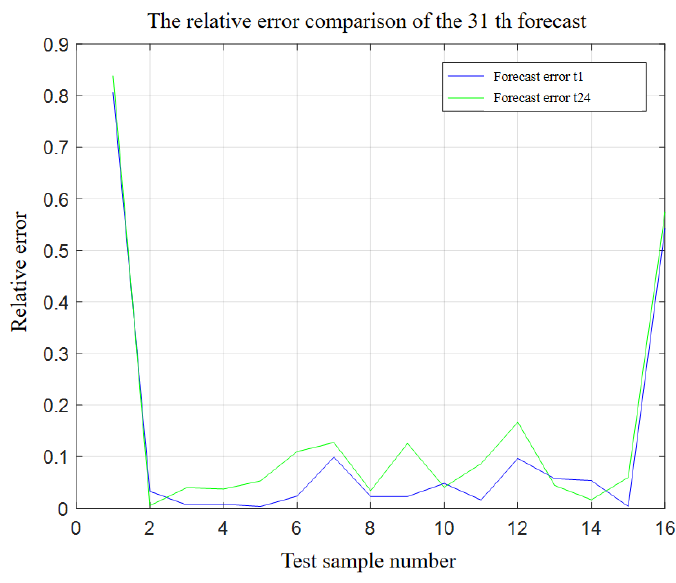
Figure 46. The relative error plot of the test set.